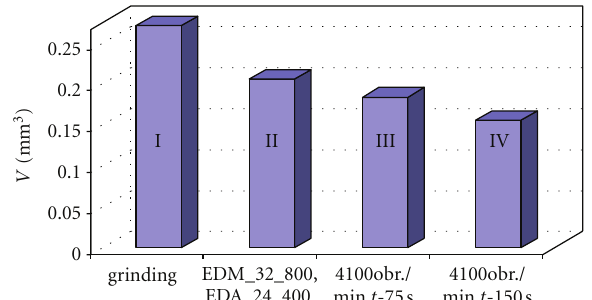
Figure 15: Comparative results. Investigation of abrasive wear resistance measured with Skoda-Savin method: (I) samples of steel 45 machined by grinding, (II) EDM U = 180 (V), I = 32 (A), Ti = 800( μ s) and EDA: U = 200 (V), I = 24 (A), Ti = 400 ( μ s); (III, IV) EDM, EDA and with roto peen: n = 4100 (rev/min) for the time of: t = 75 (s) (III); t = 150 (s) (IV) . (lubrication free conditions– specimen immersion in potassium dichromate).